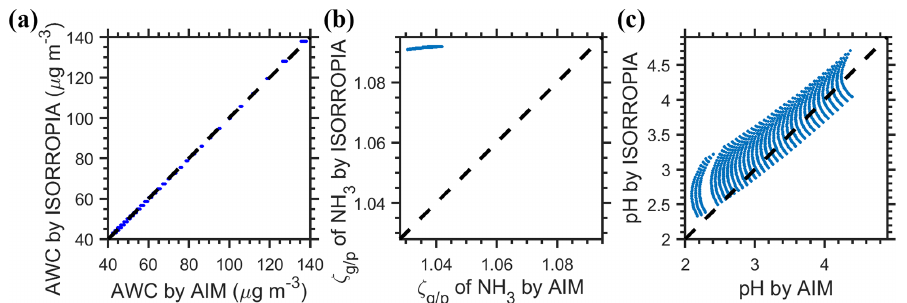
Figure C1. Same as Fig. 5, but based on EMAC results.